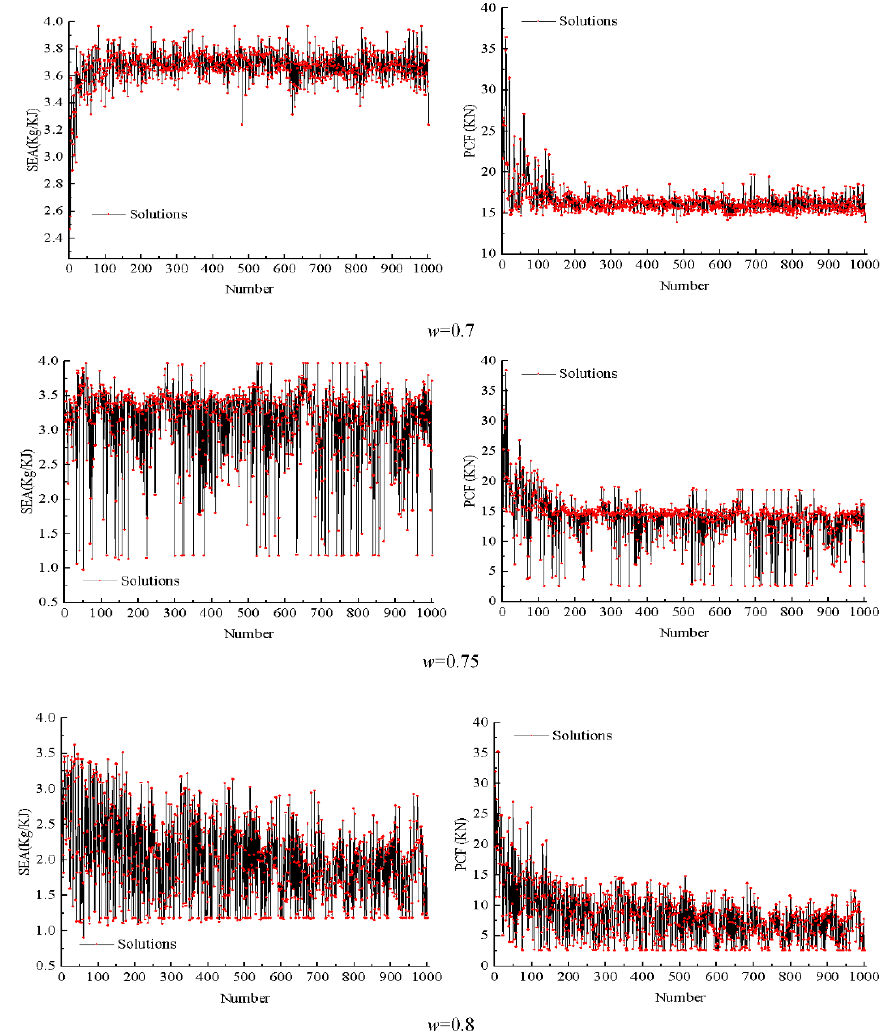
Figure 11. The solutions of SEA and PCF under different inertia weights.